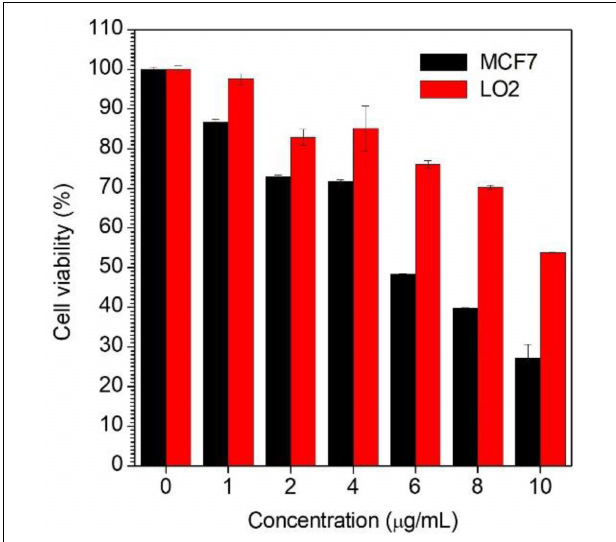
FIGURE 4 | Cell viability determined by CCK-8 assay against MCF7 cells and LO2 cells upon 48 h treatment with CPPG-AIE